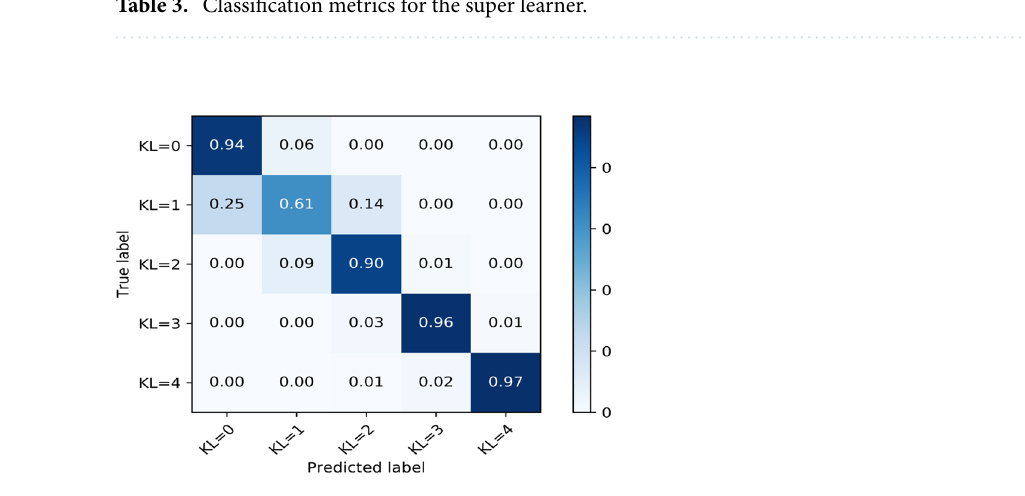
Table 3. Classification metrics for the super learner.